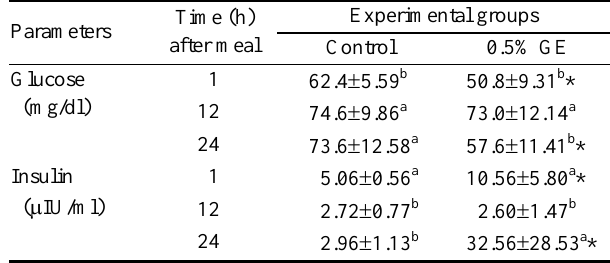
Table 6. Postprandial glycaemic response of juvenile